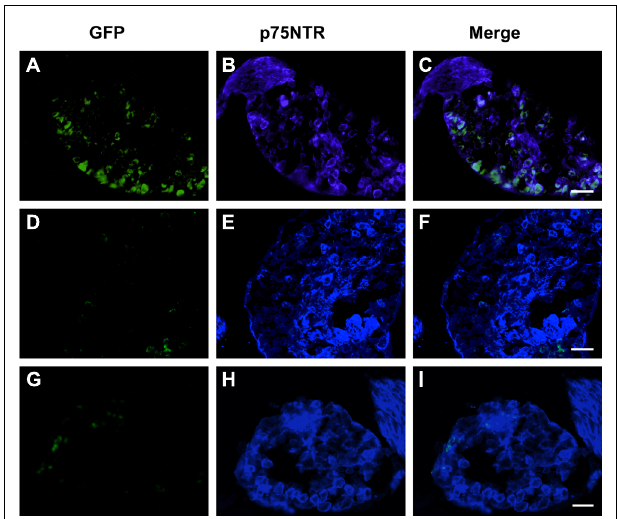
FIGURE 7 | MLR2-PEI-PEG12-pVIVO2 is retrogradely transported to dorsal root ganglia (DRG)s in neonatal mice and GFP expressed. Two doses of 75 μ g of MLR2-PEI-PEG12-pVIVO2 carrying 58 μ g pVIVO2 (N/P 12) was injected into neonatal mice and 72 h L2-L4 DRGs excised and examined for GFP expression ( n = 5). GFP expression was identified with chicken anti-GFP (1/500) and p75NTR with goat anti-p75NTR (1 μ g/ml). GFP fluorescence in DRG sections was detected after treatment with chicken anti-GFP (1/500; A ) that also contained p75NTR ( B , C scale bar: 50 μ m).Two doses of 75 μ g of PEI-PEG12-pVIVO2 carrying 77.3 μ g pVIVO2 (N/P 5) was also injected into neonatal mice and 72 h later spinal cords excised and examined for GFP expression ( n = 3). DRG sections did not contain GFP fluorescence (D) in neurons that also contained p75NTR (E,F ; scale bar: 50 μ m E,F ). Control mice non-injected DRG sections did not contain GFP (G) but did contain p75NTR ( H,I ; scale bar: 50 μ